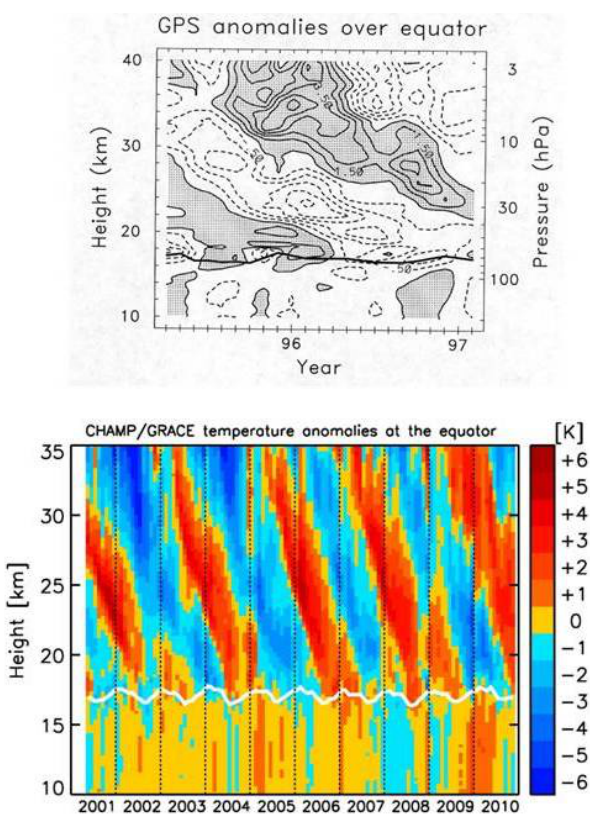
Fig. 15. Amplitudes of the diurnal tide near 30km as a function of latitude and month from the (top) CHAMP RO observations (May 2001–August 2005) and (middle) Canadian Middle Atmo- sphere Model (CMAM) and (bottom) GSWM02 model simulations. The contour interval is 0.25K (Zeng et al.,